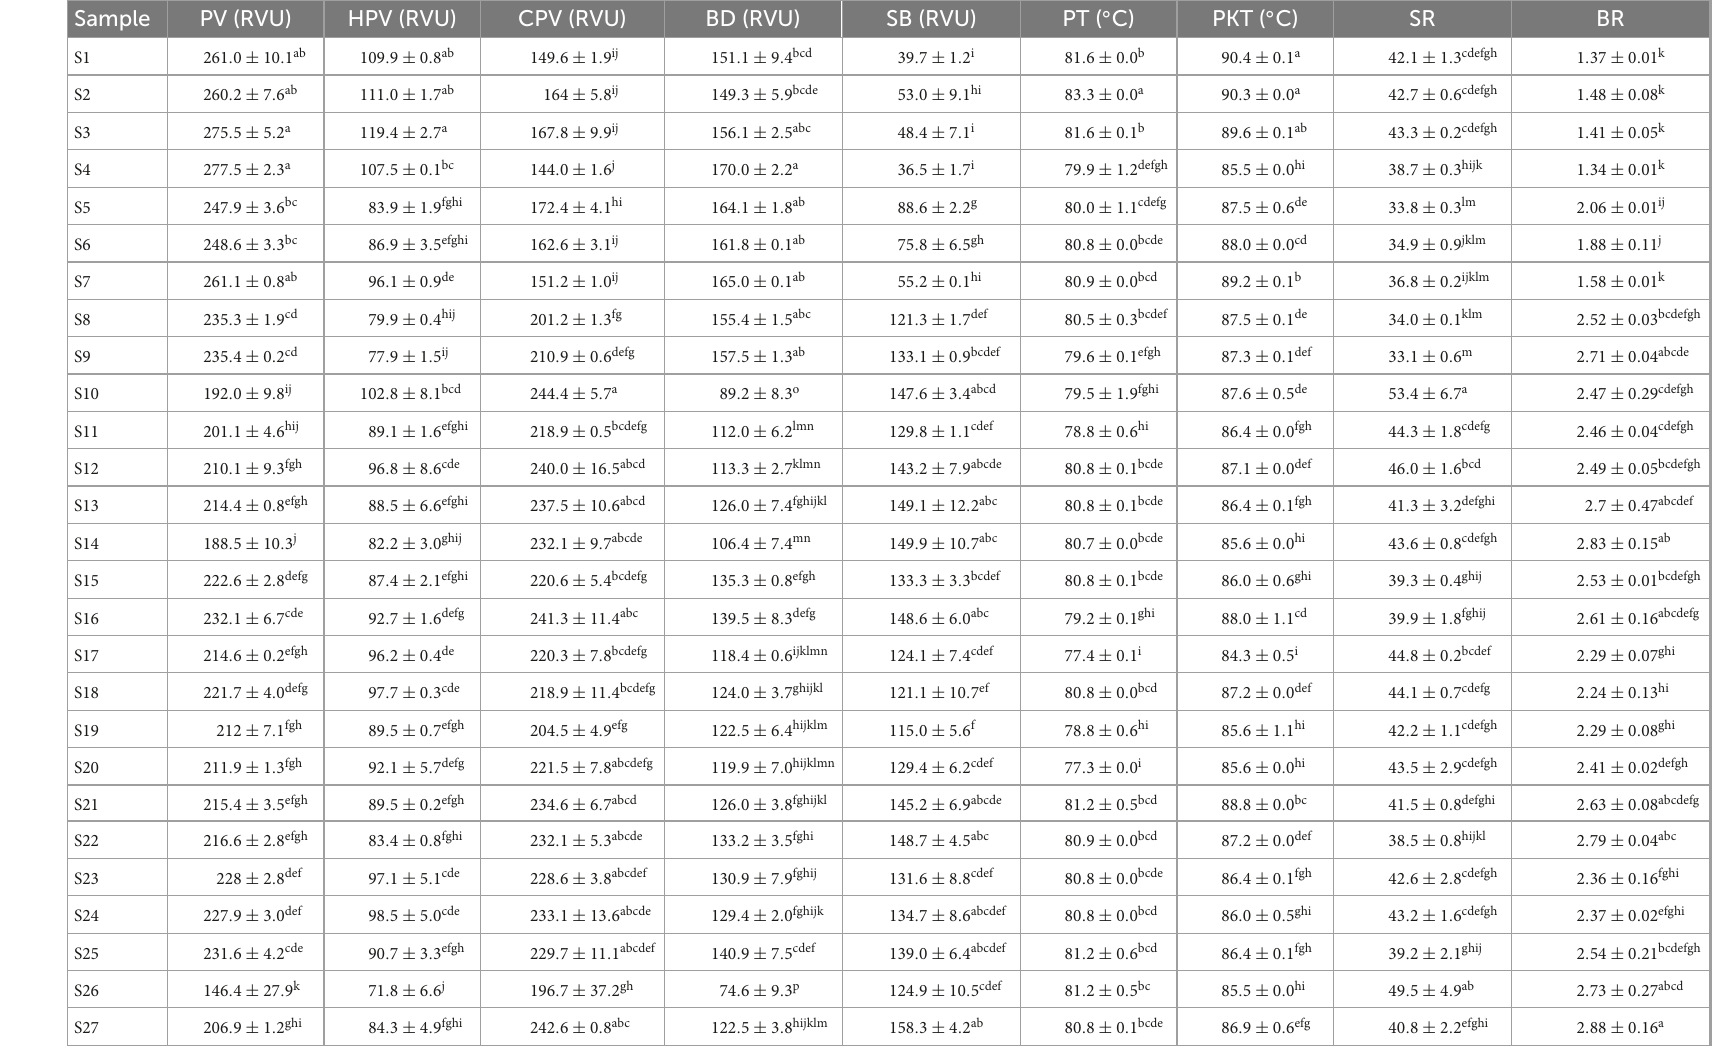
TABLE 3 Pasting properties of sorghum